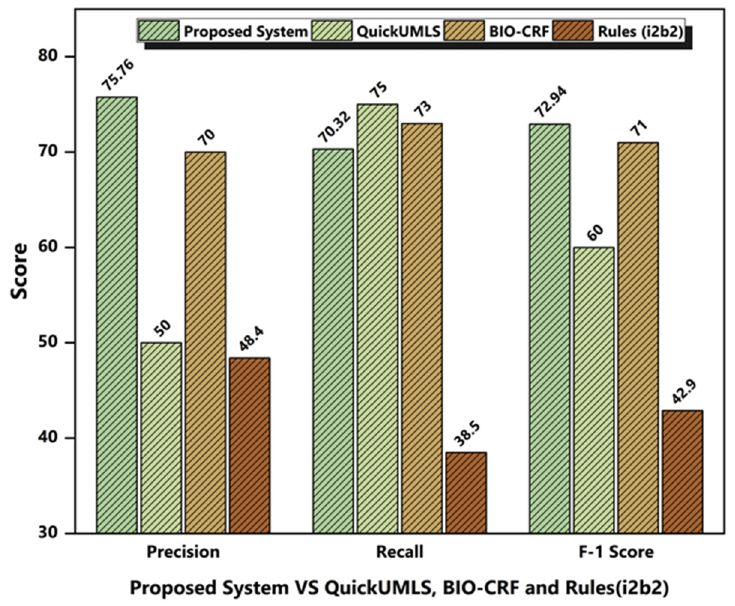
Figure 7. Performance comparison of the proposed system with the QuickUMLS, BIO-CRF, and Rules (i2b2) models.